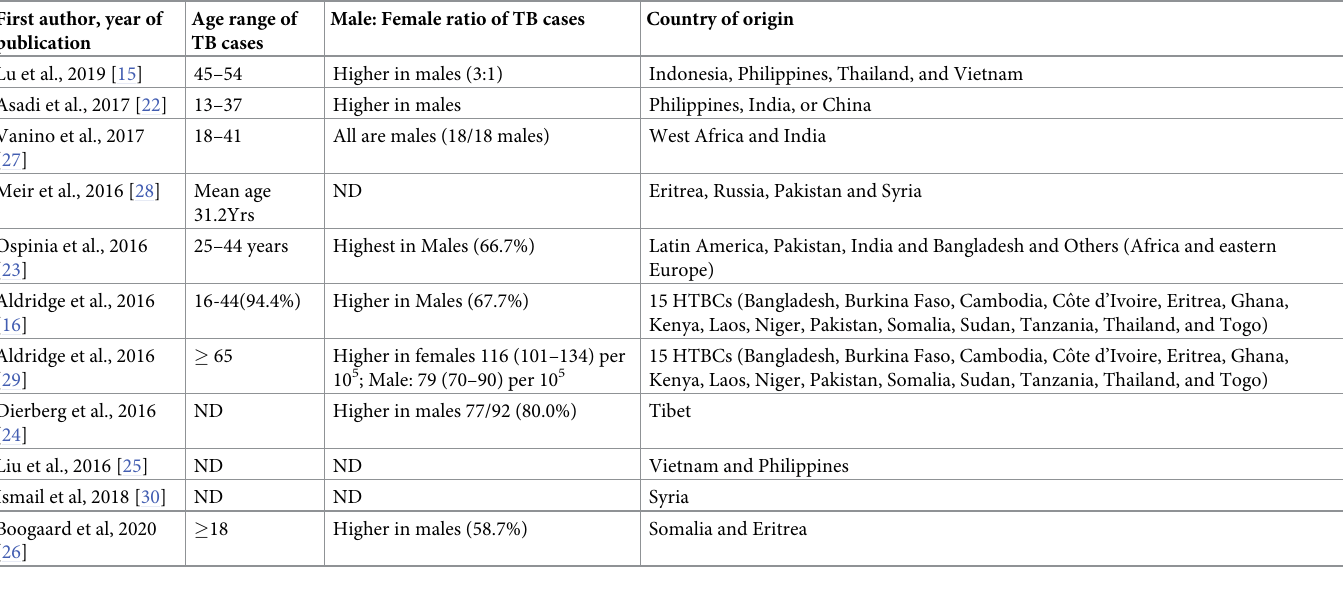
Table 3. Age range, gender and country of origin of notified TB cases across the included